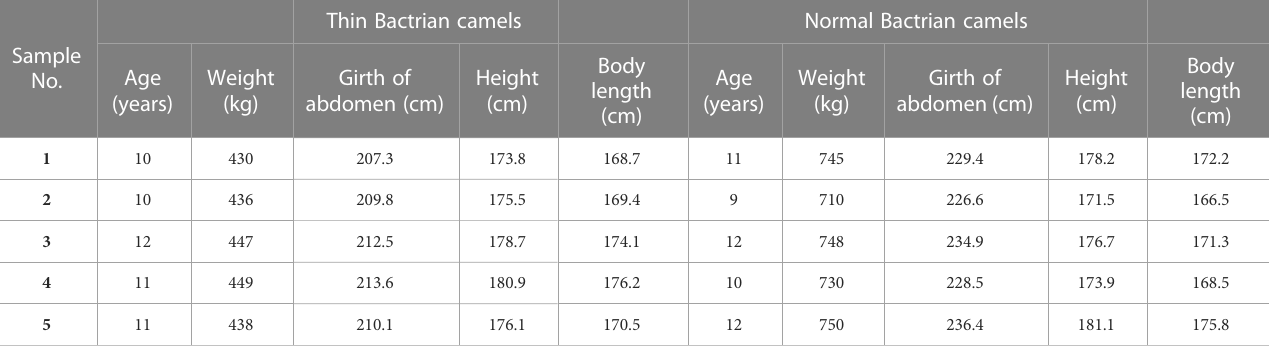
TABLE 1 Detailed characteristics of two groups camels in this study.